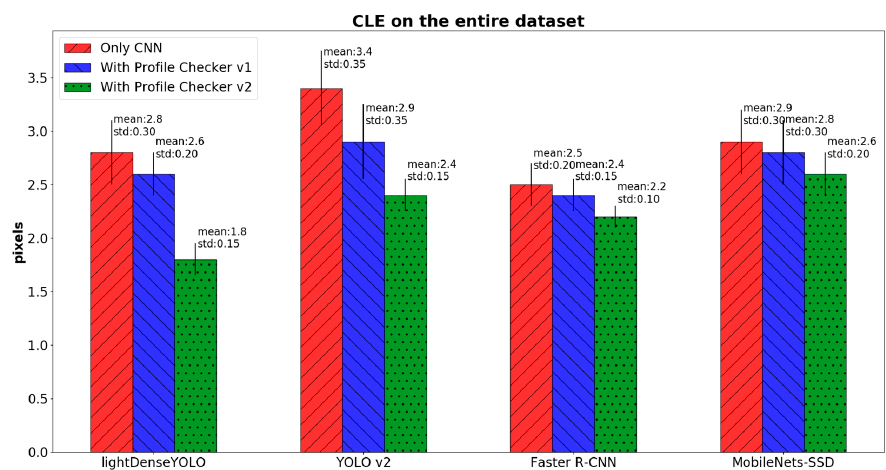
Figure 18. Comparison of CLE of entire DDroneC-DB2 dataset of various methods.